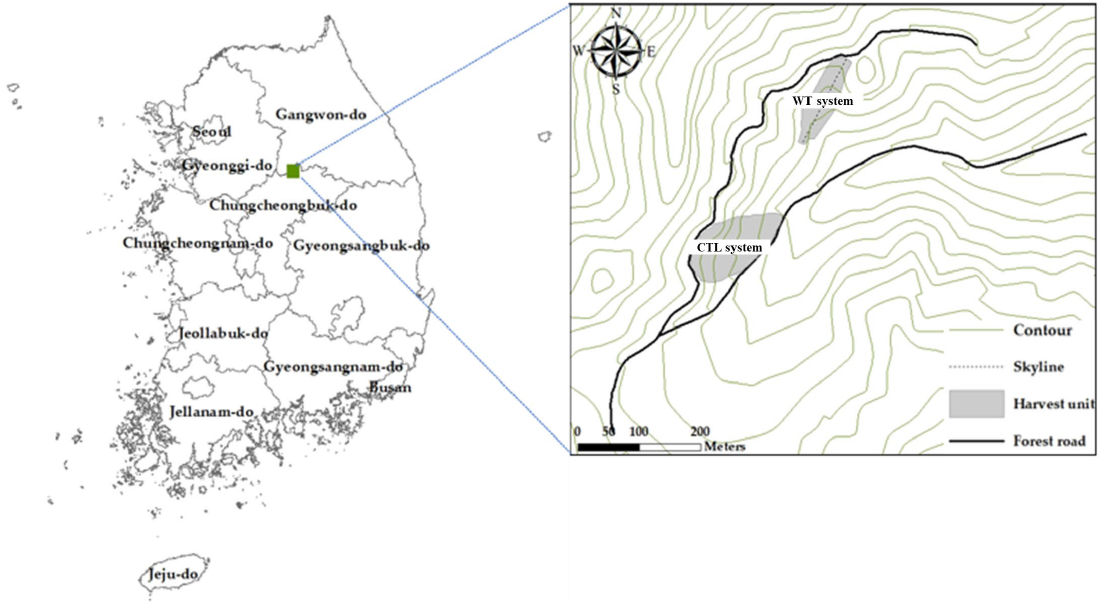
Figure 1. Harvesting unit in the forest of the National Forestry Cooperative Federation.